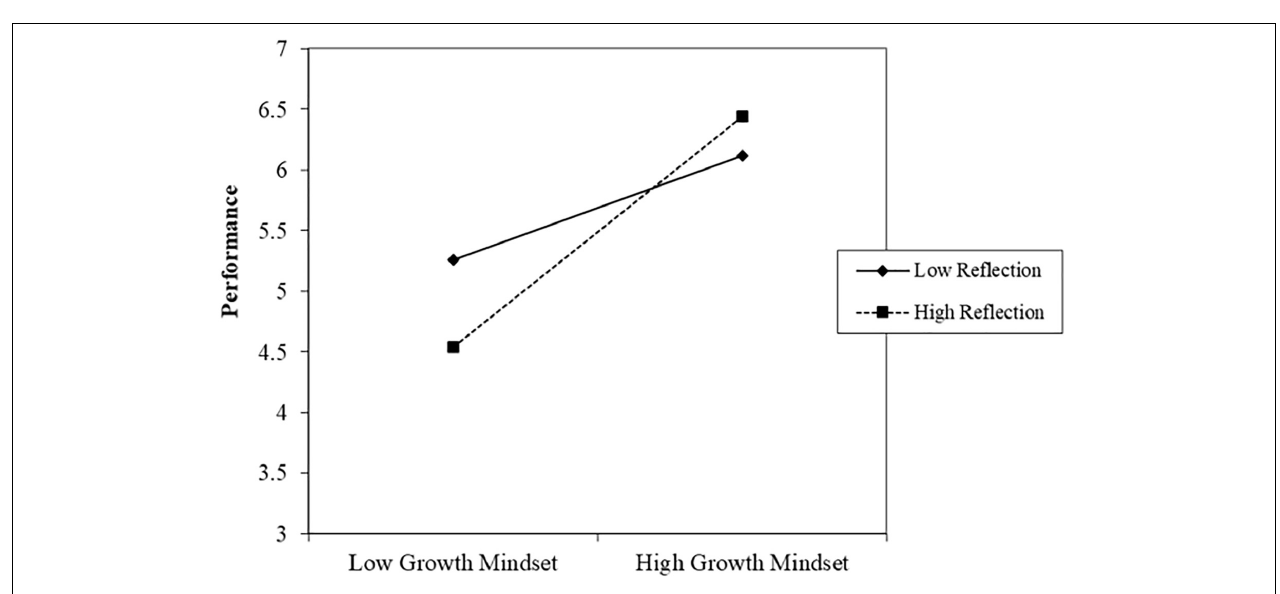
FIGURE 4 | Self-reflection on growth mindset and